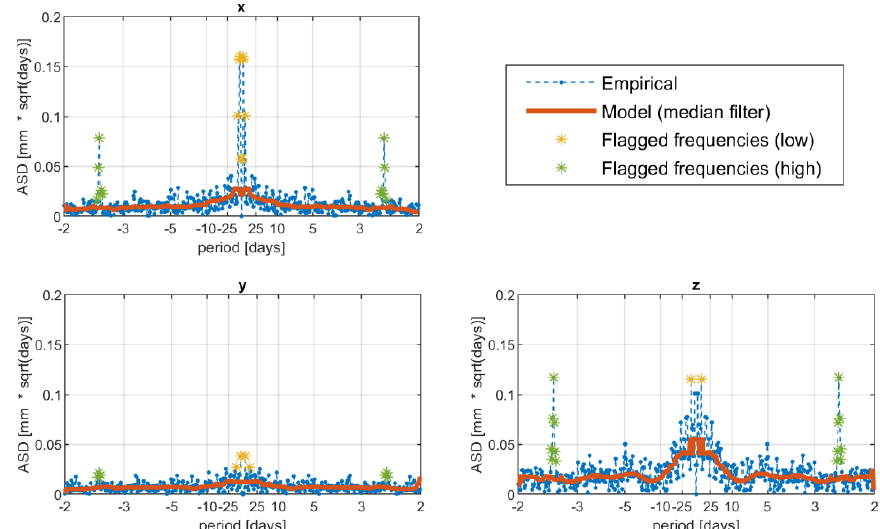
Figure 3. Fourier analysis on the x, y, z components of the point PT1. Dashed blue line is the empirical ASD, red solid line is the model ASD computed by the median filter, and yellow and green stars are the identified periodical components in the low and high-frequency ranges, respectively.